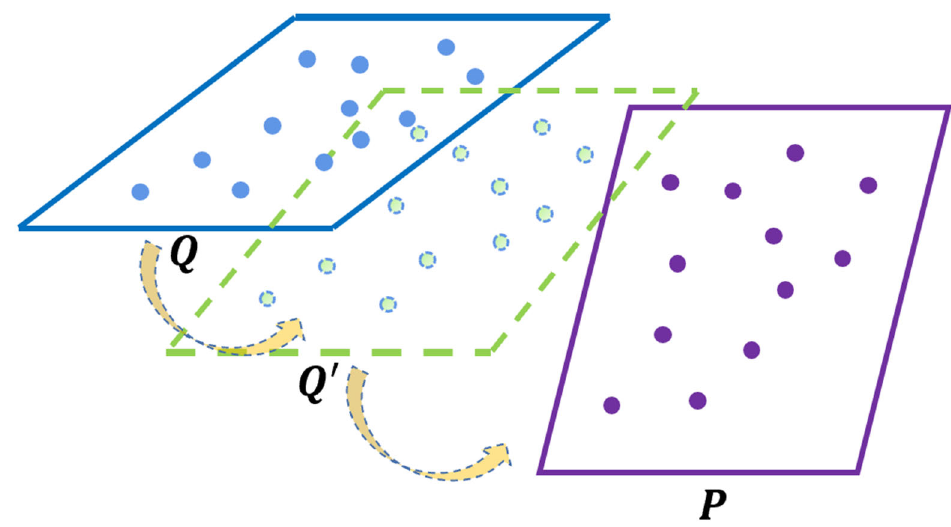
Figure 8. Registration with dynamic iteration factors.